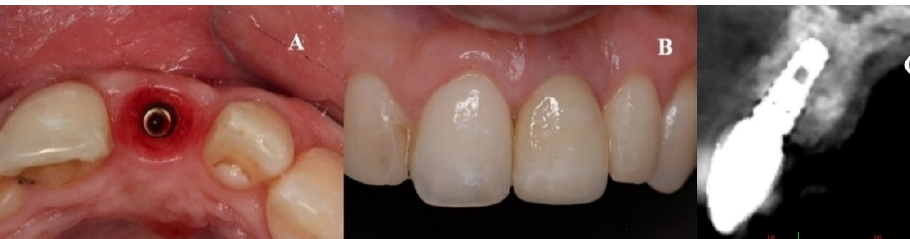
Figure 9. ( A–C ) Placement of the porcelain crown.